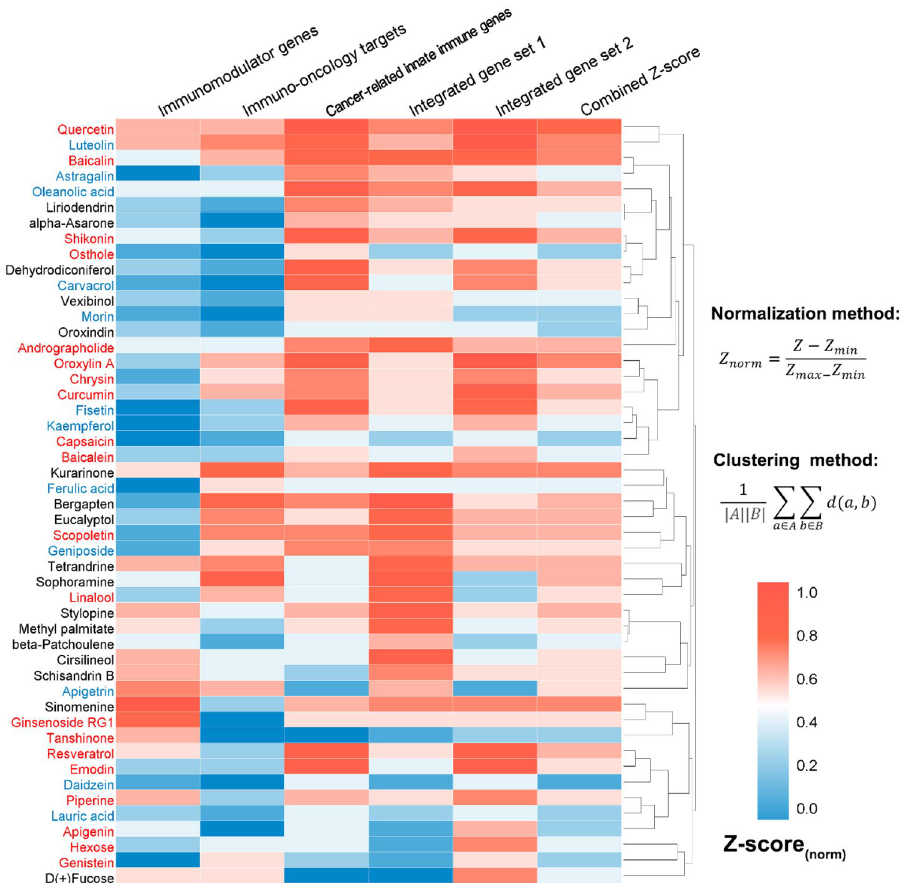
Figure 6. Heatmap highlighting the 49 natural products simultaneously predicted as potential cancer immunotherapeutic candidates by all the five statistic network models. The relative metric combined Z-score was calculated for each natural product by averaging the normalized Z-scores predicted by the five models. Natural products validated by direct evidence and indirect evidence are highlighted in red and blue font, respectively. The heatmap was drawn using HemI (v1.0) 38